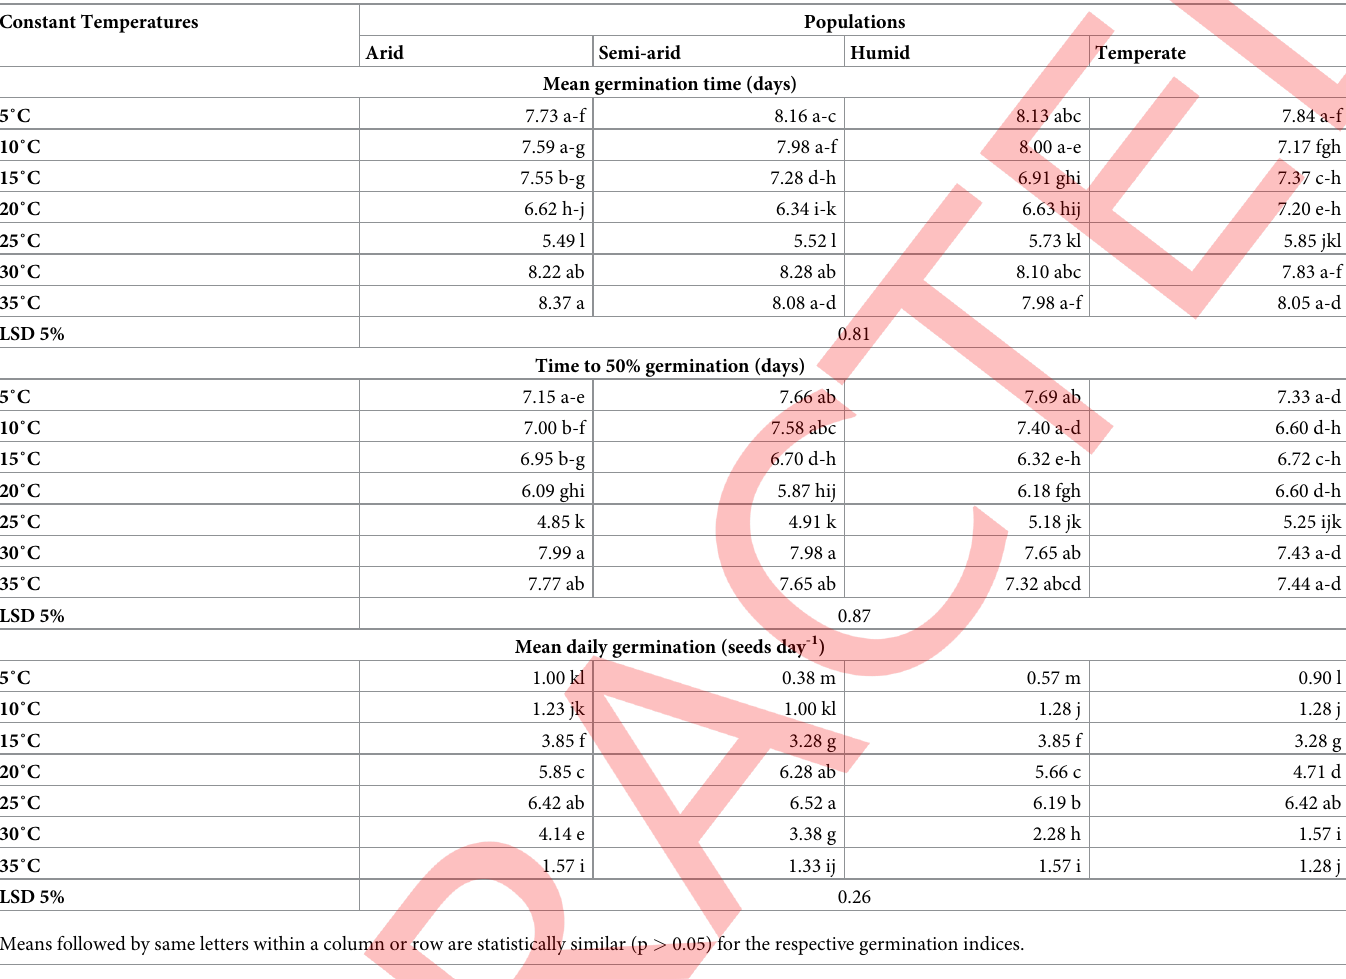
Table 4. The impact of different constant temperatures on various germination indices of Conyza sumatrensis populations collected from varying climatic regions.